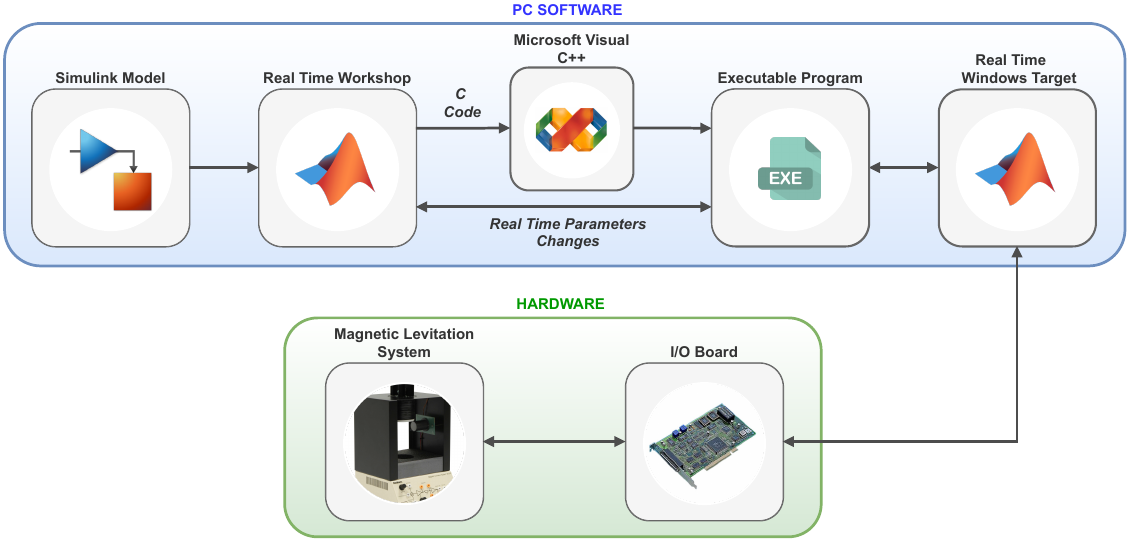
Figure 14. Control System Development Flow